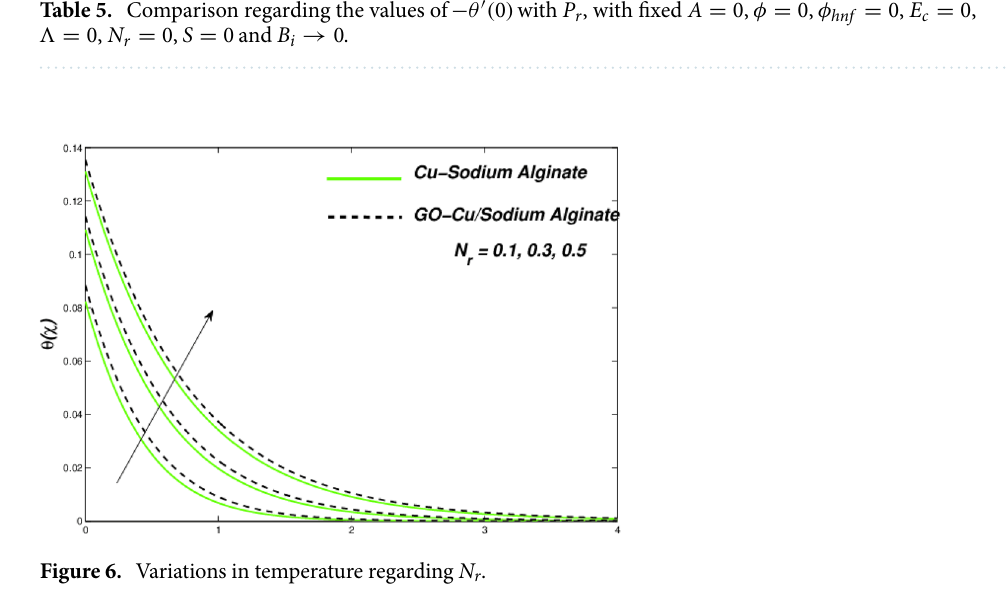
θ ′ ( 0 ) with P r , with fixed A −